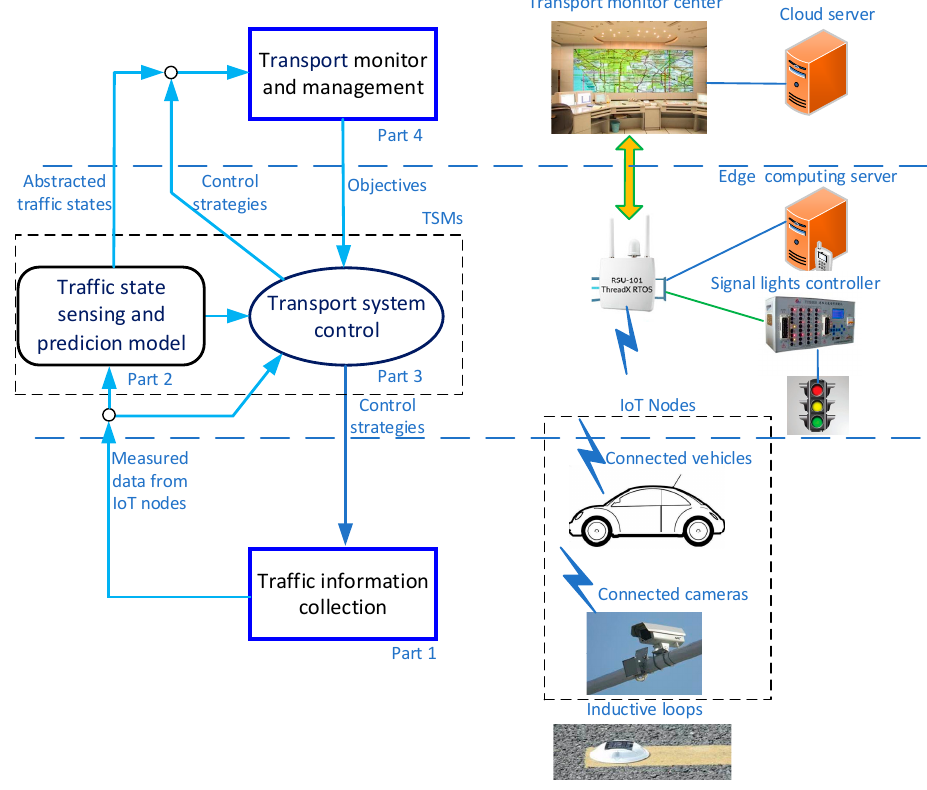
Figure 1. Architecture of Intelligent Transportation System .